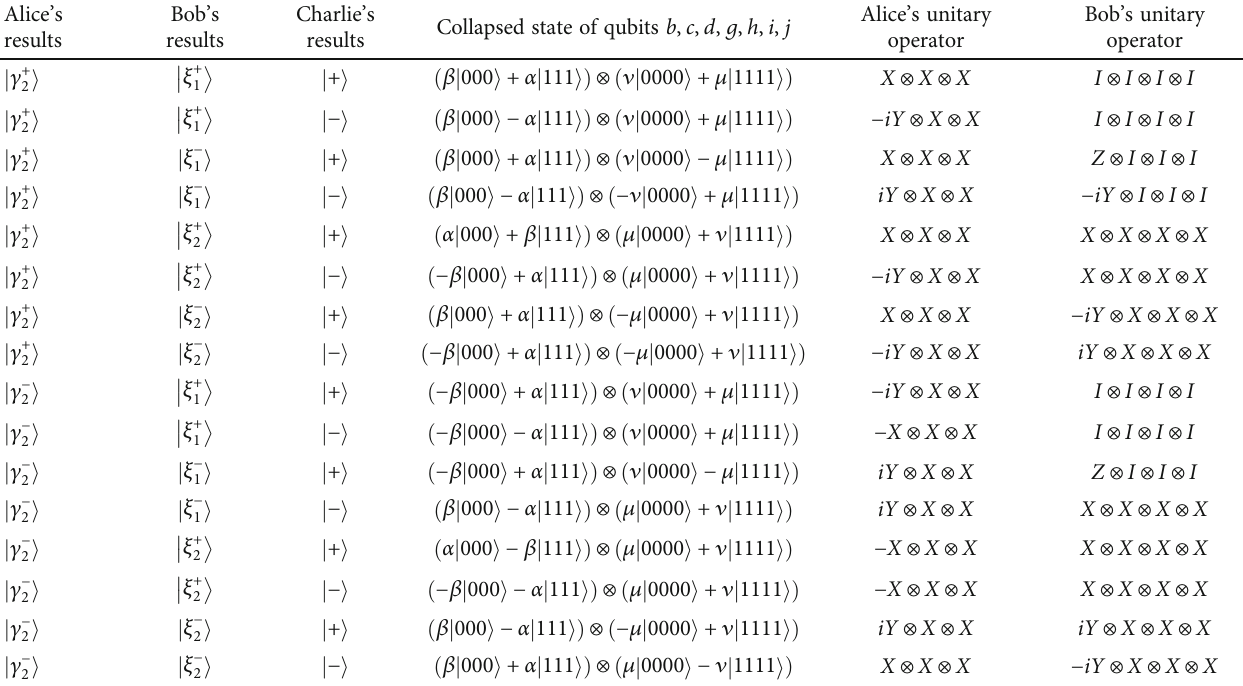
Table 3: Following the above table.